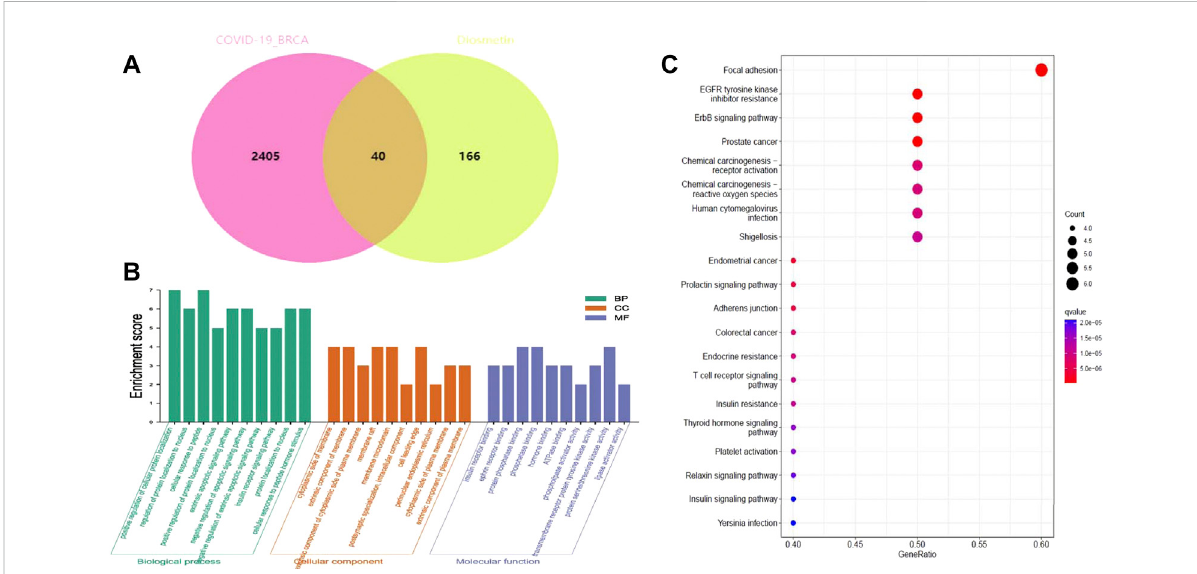
FIGURE 6 Functional identi fi cation of BRCA/COVID-19 crossover genes by Diosmetin. (A) Venn diagram of the intersection of Diosmetin and BRCA/ COVID-19genes. (B) GeneOntologyanalysisofDiosmetinandBRCA/COVID-19intersectinggenes. (C) KyotoEncyclopediaofGenesandGenomes (KEGG) pathway for Diosmetin and BRCA/COVID-19 gene